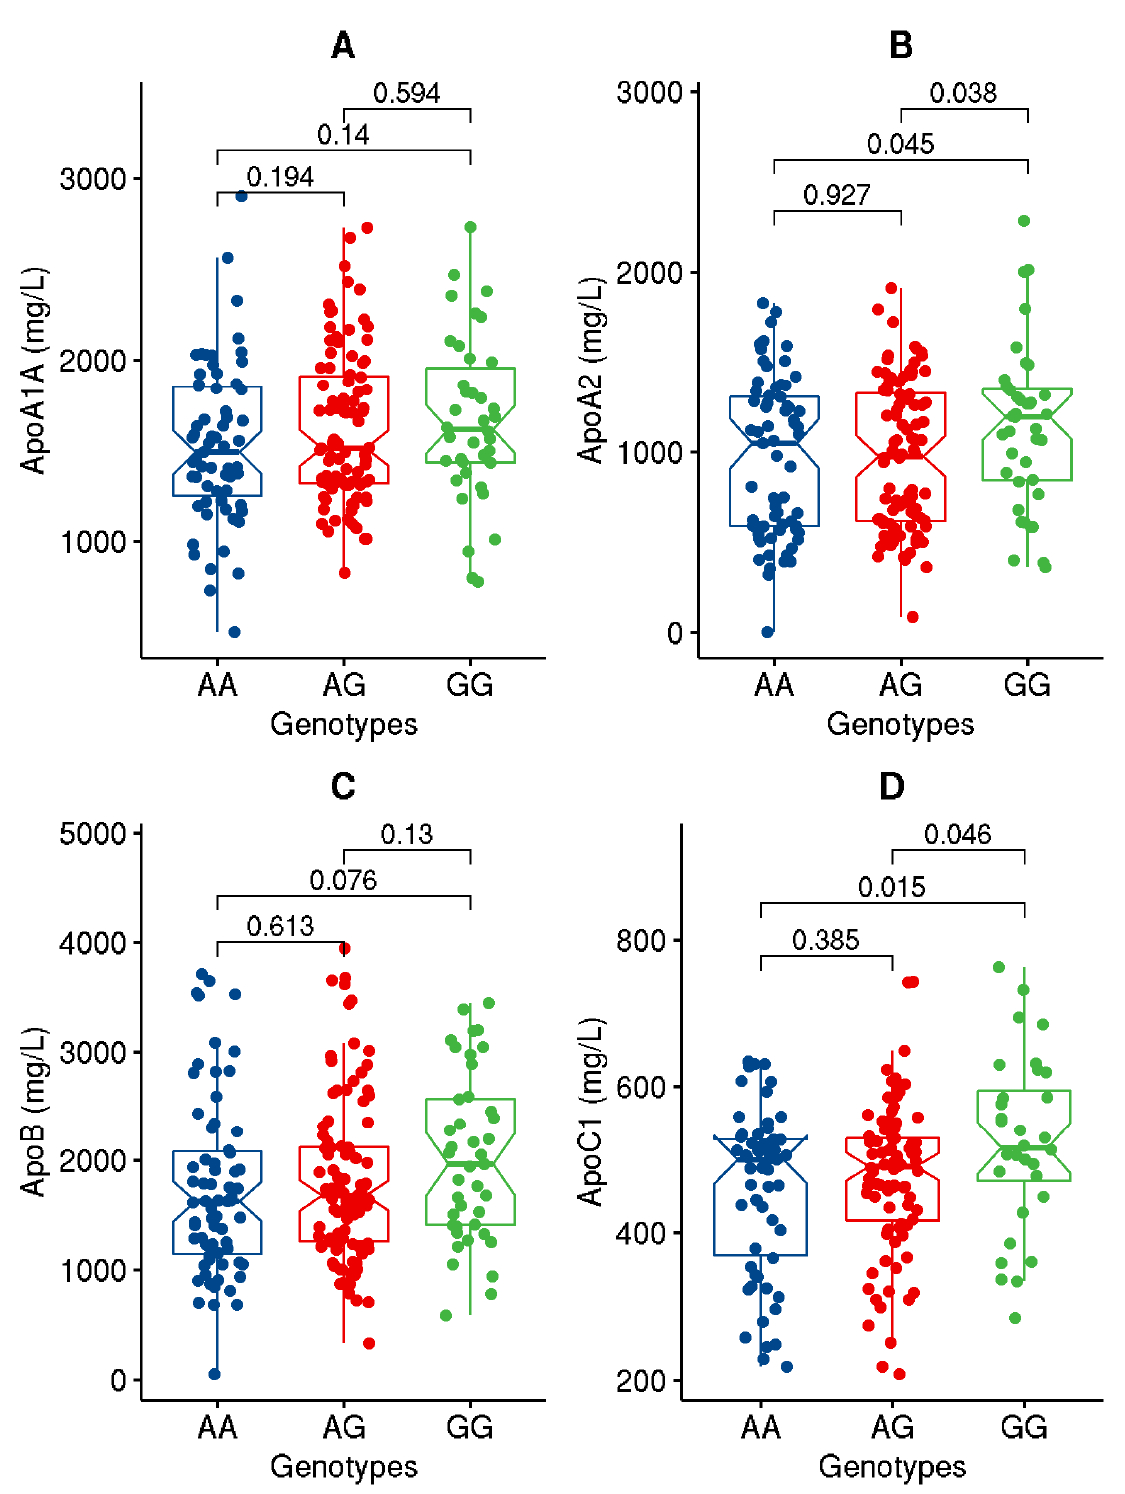
Figure 4. Data distribution for the levels of Apolipoproteins, namely ApoA1A ( A ), ApoA2 ( B ), ApoB ( C ), and ApoC1 ( D ), in individuals with genotypes homozygous for major allele (AA) versus geno- types homozygous for effect allele (GG) or for the heterozygous genotypes (AG). The boxplot illus- trates minimum and maximum values in the range, first quartile, median, and third quartile for each of the genotype groups.